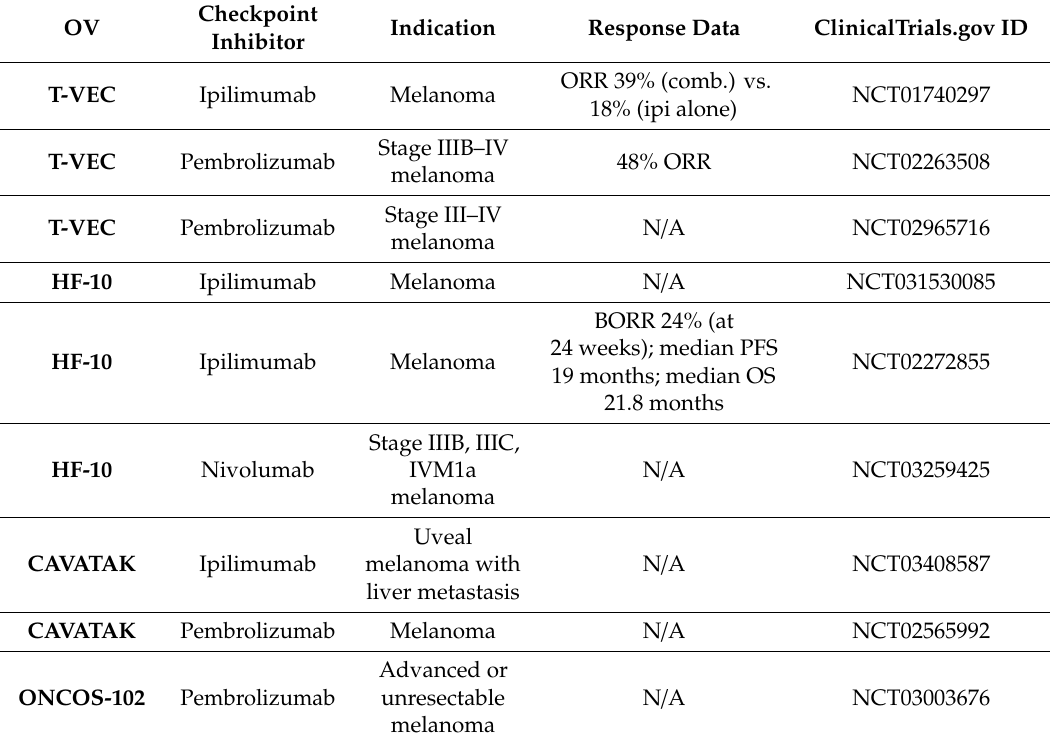
Table 1. The combinatory therapy of oncolytic vectors and CPIs for melanoma